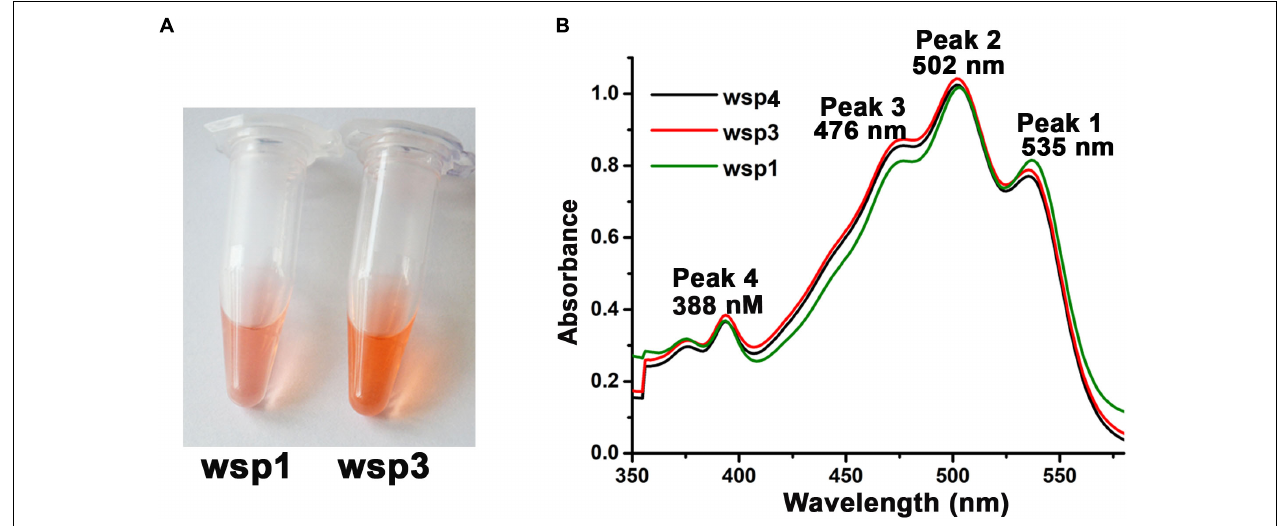
FIGURE 3 | Isolation and biophysical characterization of haloarchaeal carotenoids isolated from wsp1, wsp3, and wsp4 isolates. (A) The microcentrifuge tubes containing purified carotenoids from equal culture volume of the two haloarchaeal strains showing observable color variations. (B) UV–visible absorption spectra of the purified carotenoids showing four carotenoid standard peaks (peak I–IV) at 535, 502, 476, and 388